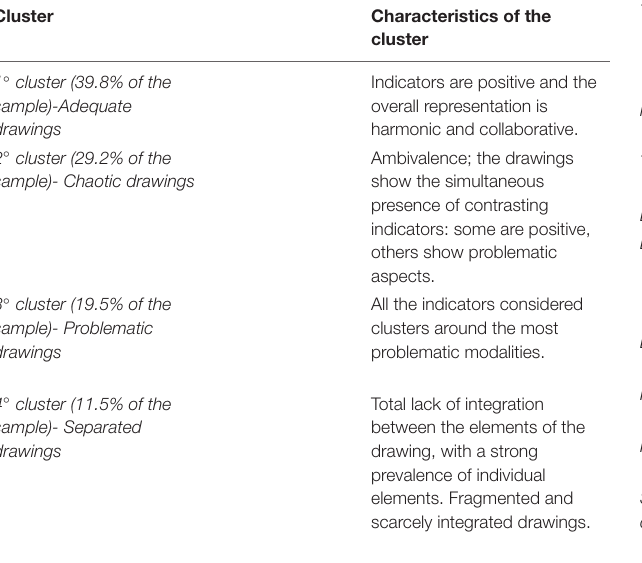
TABLE 3 | Cluster analysis on the outcome indicators. Cluster Characteristics of the